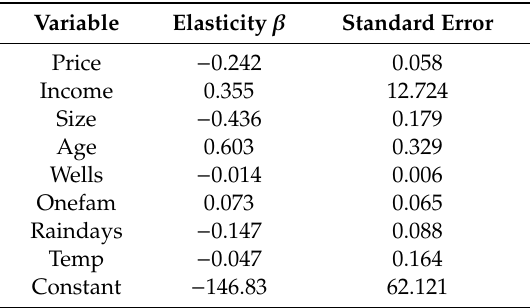
Table 2. Estimation results for water demand for the log-log model with the sample size of 592. Source: